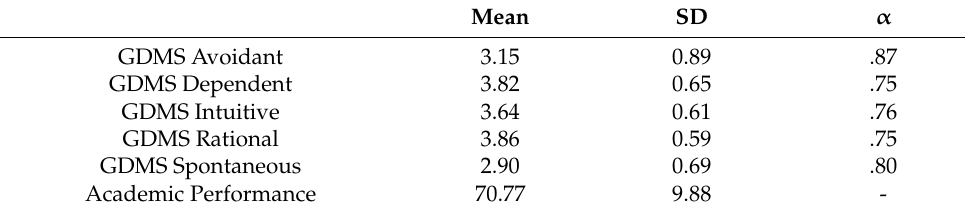
Table A1. Descriptive statistics and reliabilities for decision-making variables and academic